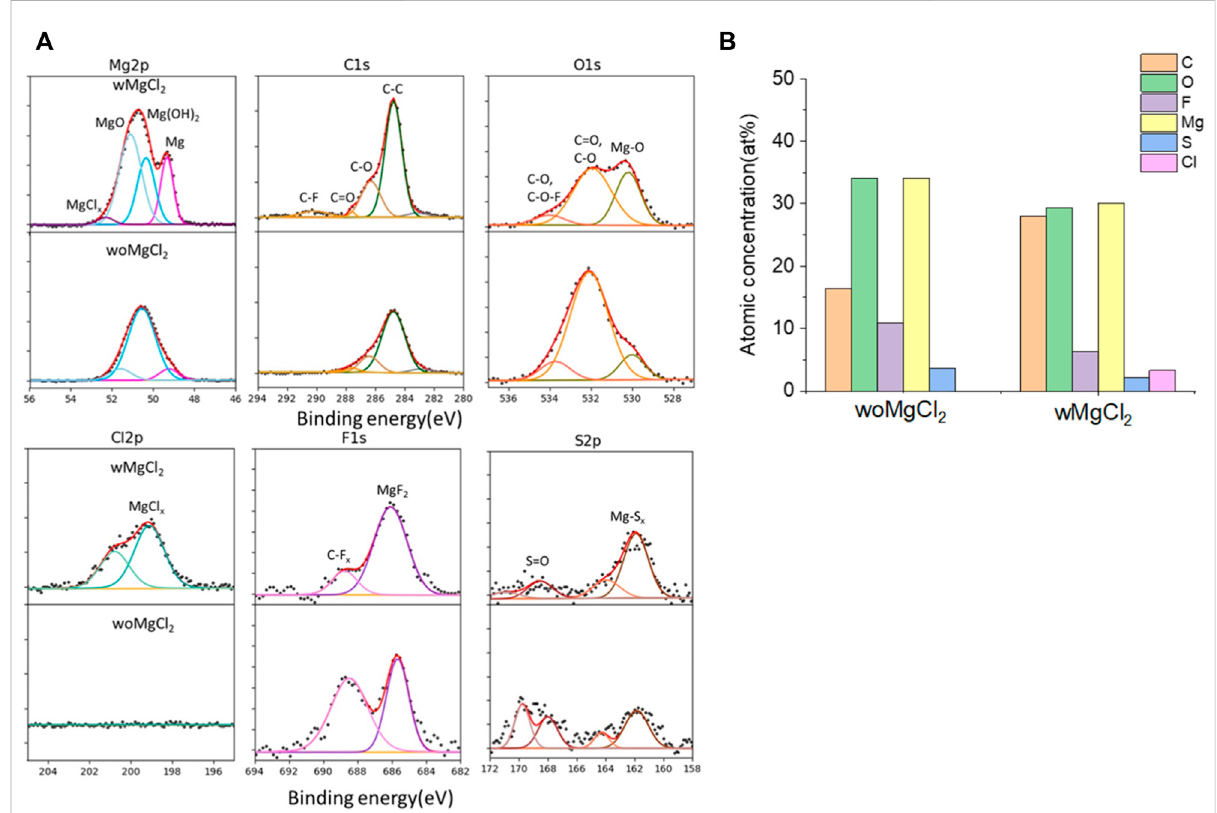
FIGURE 5 (A) High-resolution XPS spectra of Mg 2p, C1s, O1s, Cl 2p, F 1s, and S 2p on the surface layer of the cycled Mg electrode with/without MgCl 2 in